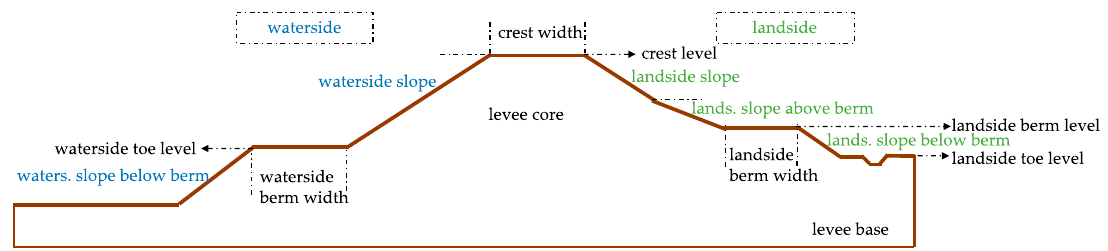
Figure 2. General levee cross section, showing the main elements of a levee included in the ILPD.